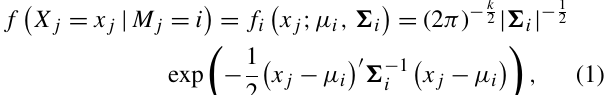
ship at that volume ( M j = 1 for “ice,” M j = 2 for “liquid,” etc.). The likelihood functions of the data f